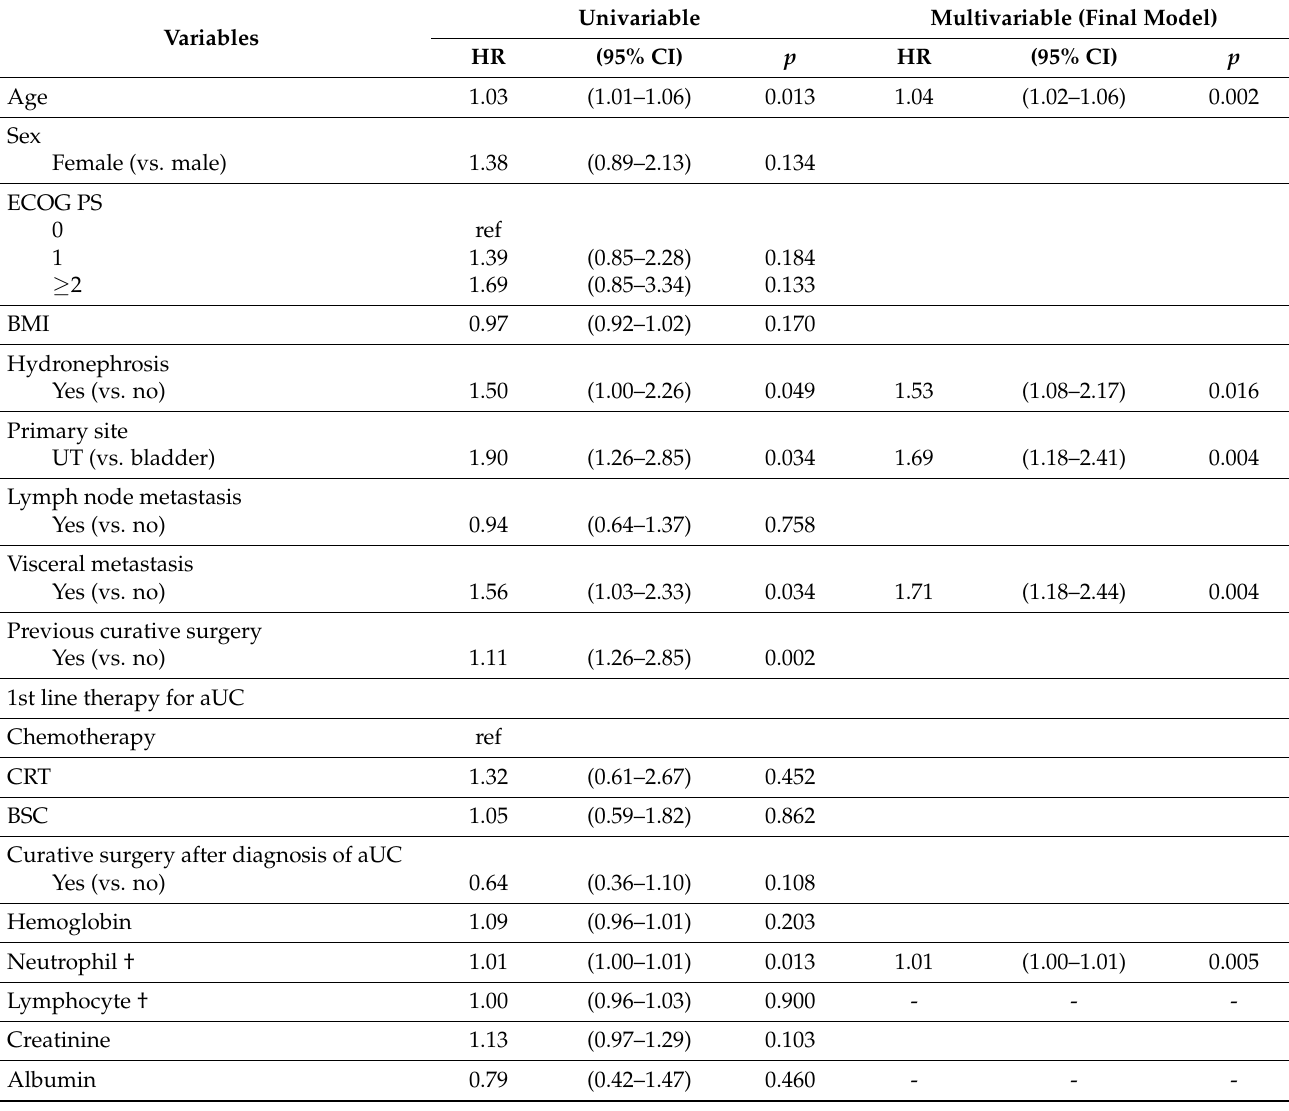
Table 4. Univariable and multivariable analyses of overall survival in 200 patients with advanced urothelial carcinoma.